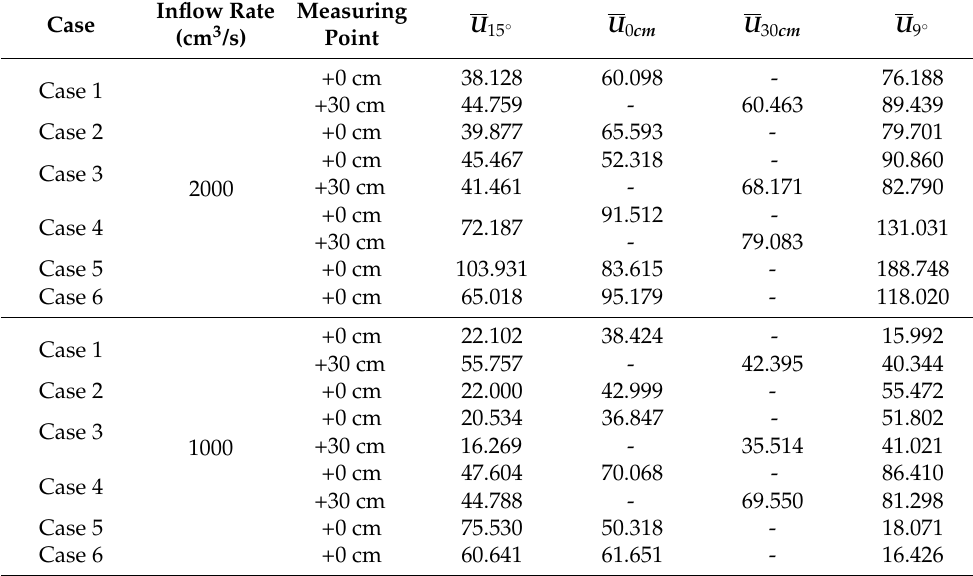
Figure 7. Comparison of theoretical velocity distribution as suggested by Takahashi et al. [34] and measured migration velocities for case 2 on uniform gradients of 15° and 9°. The main parameters used to obtain the theoretical velocity distribution were the mass density of gravel ( σ ) = 2650 kg/m 3 , internal friction angle ( ø ) = 32°, and concentration in the static sediment bed ( C * ) = 0.650. Table 4. Averaged gravel migration velocities within the “median depth” in the interior of the “frontal part”, 𝑈̅ , and theoretical migration velocities of gravel within the “median depth” on the uniform gradients, 𝑈̅ 15° , 𝑈̅ 9° , for all cases with two supplied water rates (unit; cm/s)